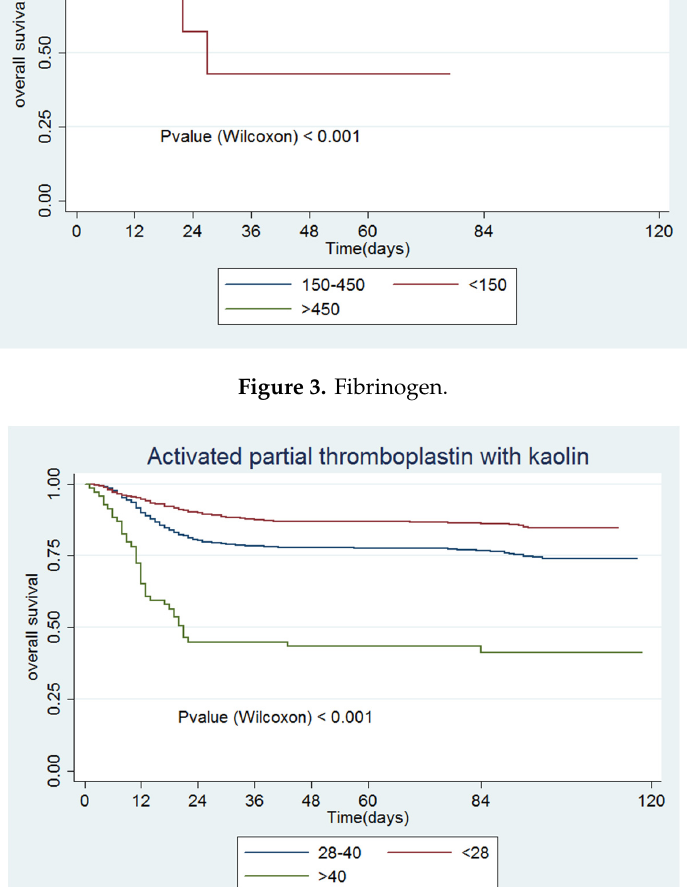
Figure 4. Activated partial thromboplastin time with kaolin.